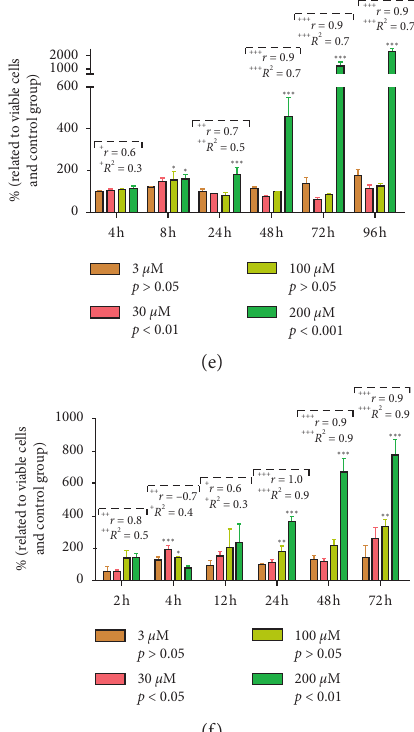
Figure 1: Viability, cytotoxicity, and caspase-activity assays in HepG2 and DLD-1 cells. (a) A very pronounced limitation of HepG2 viability in terms of a cytostatic effect already was observed after a 2-hour incubation with I-ol, as indicated by the relative fluorescence units (RFUs) observed. (b) Comparable effects on the viability of DLD-1 cells after 8h with I-ol. (c) Reduced viabilities of HepG2 cells treated with smaller I-ol concentrations after 8h only at the highest concentration. (d) No cytostatic effect on HepG2 cell viability was caused by treatment with cyclodextrin. (e) A strong increase in relative caspase activities of HepG2 cells treated with the highest I-ol concentration was found after an 8-hour incubation. (f) Maximum relative cytotoxic effects observed in HepG2 cells treated with the highest I-ol concentration after 24-hour incubation. The significance values from the “simple main effect of time” are shown below the group designations. The results are expressed as the mean ± SD. Statistical calculations were performed based on two-way mixed ANOVA, followed by Bonferroni’s post hoc test. In all cases, the significance level was ∗ p < 0 . 05 (significant), ∗∗ p < 0 . 01 (highly significant), and ∗∗∗ p < 0 . 001 (very highly significant). Dose- dependent effects of I-ol were calculated by determining Pearson’s correlation coefficient ( r ) and performing linear-regression analysis (adjusted R 2 ) with the following statistical parameters: + p < 0 . 05 (significant), ++ p < 0 . 01 (highly significant), and +++ p < 0 . 001 (very highly